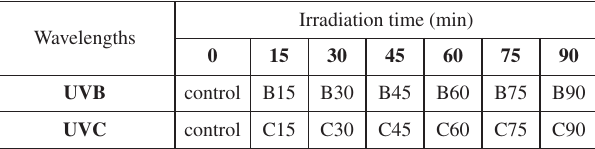
Irradiation time (min)